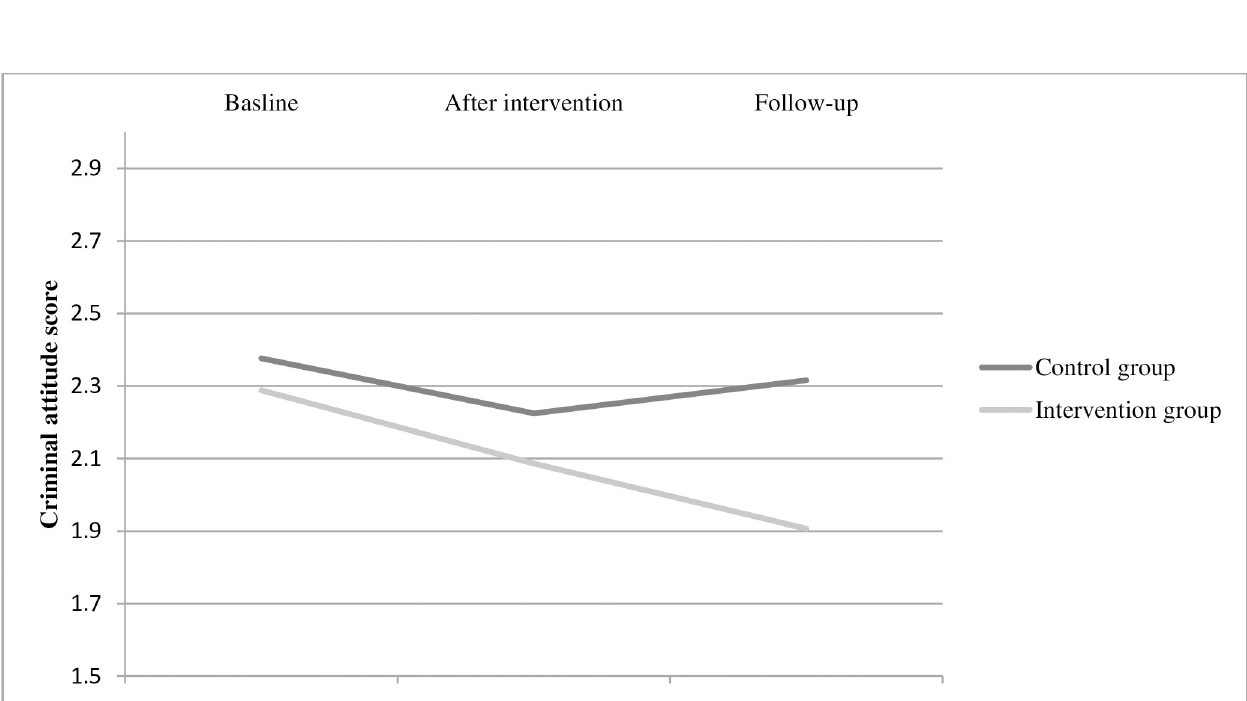
Fig 3. Mean scores for each group on criminal attitude at each time point.